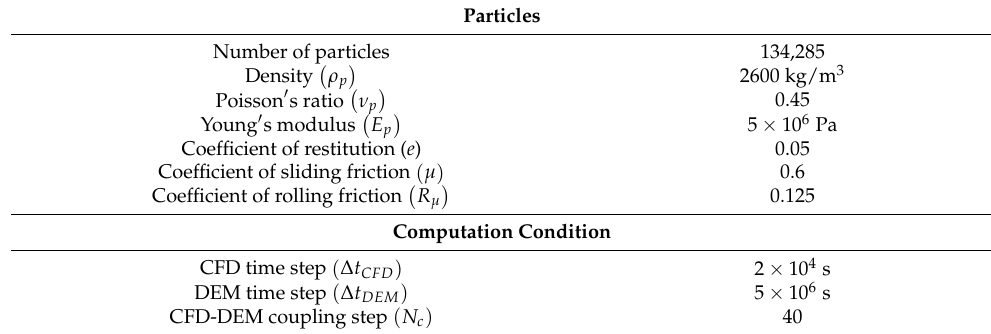
Table 2. Simulation